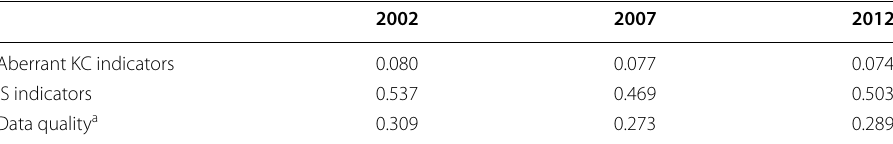
Table 8 IO data quality of national IO data